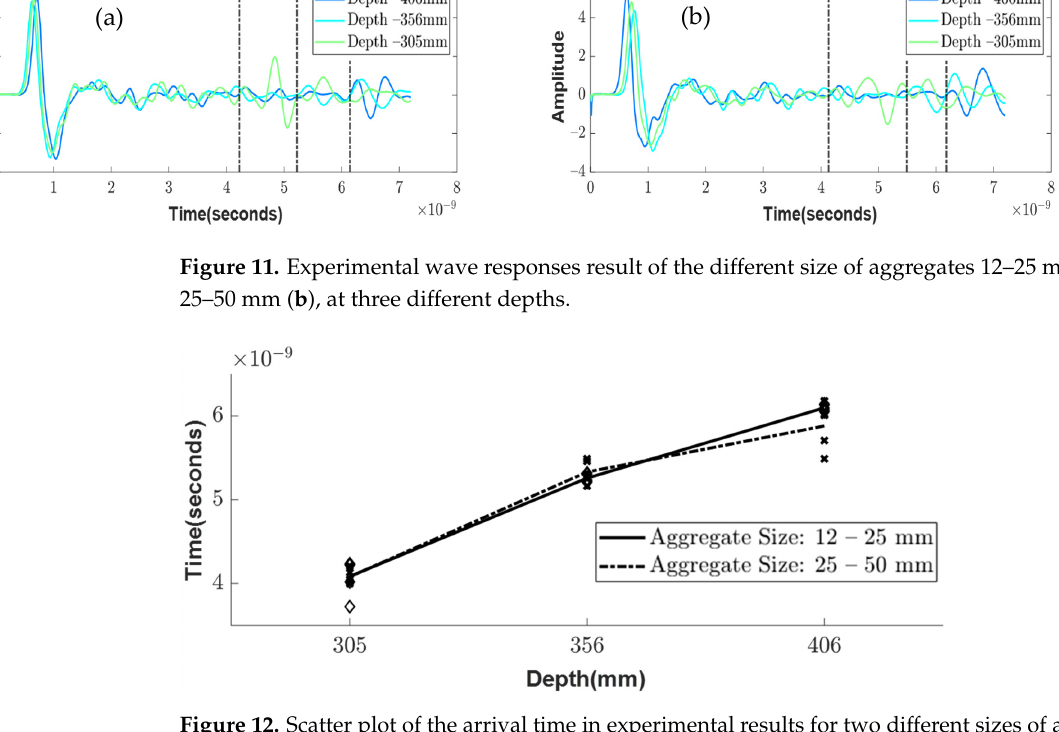
Figure 12. Sca tt er plot of the arrival time in experimental results for two di ff erent sizes of aggre- gates .